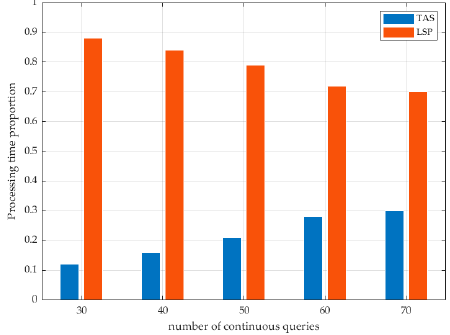
Figure 15. Service processing time proportion.